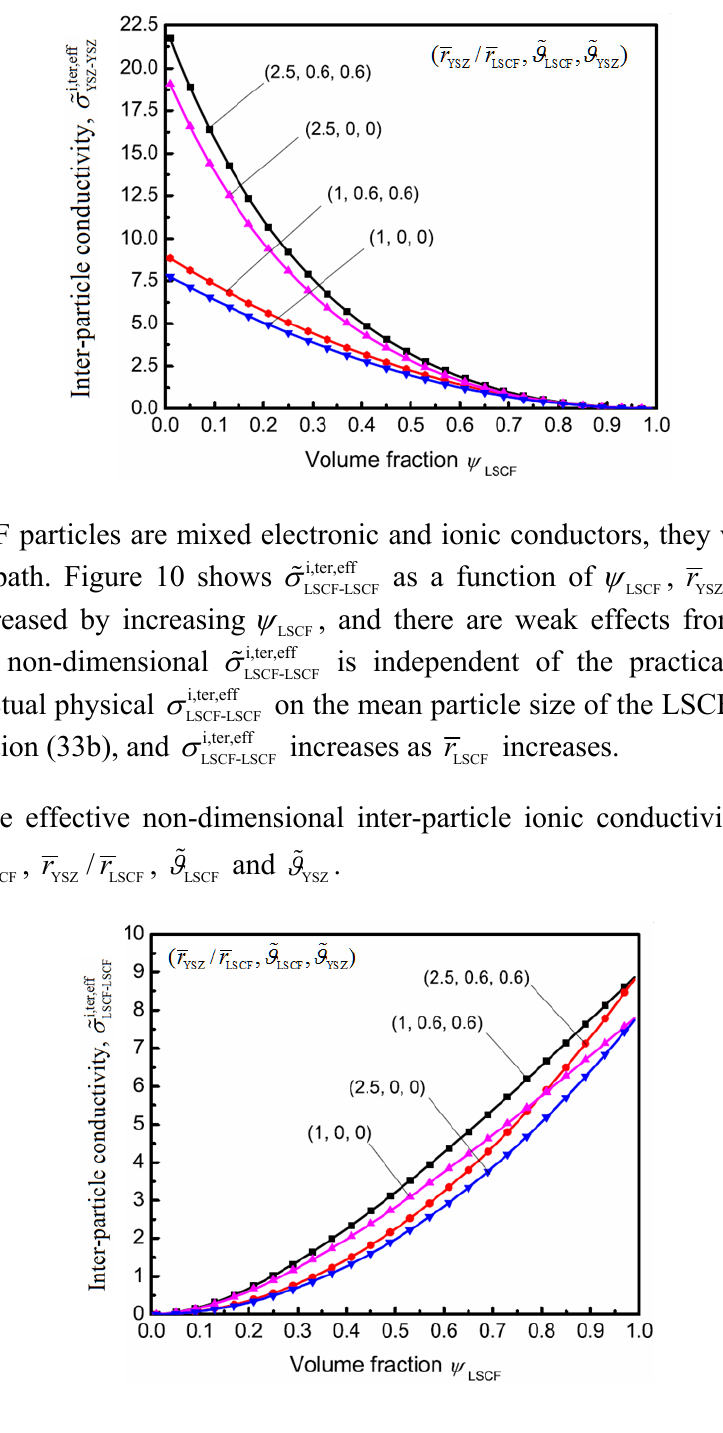
Figure 9. The effect of and on the effective non-dimensional inter-particle ionic conductivity